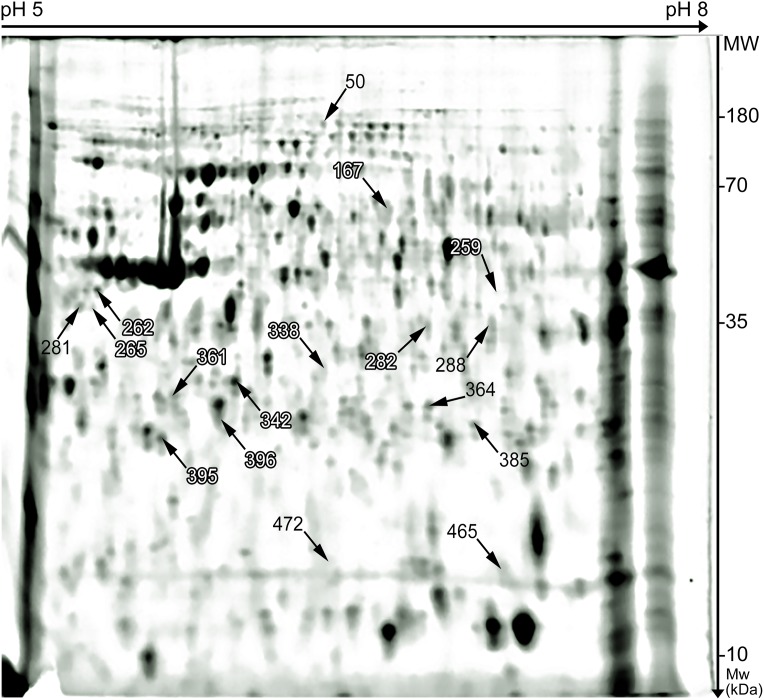
Fusion gel image of 2D DIGE experiment containing all protein spots (541) in chicken jejunum created with Delta2D software.Proteins with higher expression in the fasted for 24 h group compared to the ad libitum fed group are marked with black and proteins with lower expression are labeled with white numbers, respectively. Molecular weight marker (PageRuler 10–180 kDa, Thermo Fisher Scientific, Waltham, MA, USA) was derived from the preparative gel where it was run together with the sample proteins.